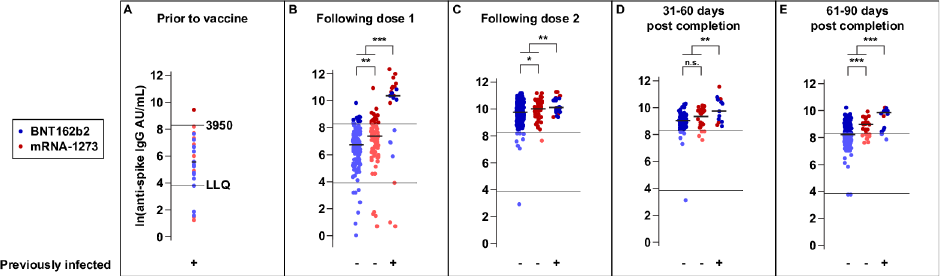
Fig 1. Longitudinal immune response to anti-Spike IgG following each vaccination dose and up to 90 days post- vaccination. Anti-Spike IgG from prior to vaccination to 90 days after completion of the vaccine schedule for participants who received BNT162b2 (blue) and mRNA-1273 (red) by prior infection status (+/-) demonstrate higher levels of anti-Spike IgG in participants with prior infection. Panel A shows participants with prior infection and their anti-Spike IgG level prior to vaccination. Panels B-E show participants with and without prior infection by vaccine type. Participants with prior infection were combined regardless of vaccine type. Anti-Spike IgG levels are shown following the 1 st dose ( Panel B ), following the 2 nd dose ( Panel C ), and 31–60 days ( Panel D ) and 61–90 days after completion ( Panel E ) of the 2-dose series. Positive anti-Spike IgG titers were defined as at or above the lower limit of quantification (LLQ). High level anti-Spike IgG responses were defined at or above 3,950 AU/mL. Horizontal black lines indicate median titer level within each group. P-values compare anti-Spike IgG titers for participants with prior infection versus no prior infection and for participants with no prior infection by vaccine type, � p < 0.05 and �� p < 0.01, ��� p < 0.001, n.s. = not significant. There were two participants on immunosuppressive medications who did not respond to vaccination (the blue dots at or below the LLQ in panels C, D, and E). Their data is shown but not included in the analyses.